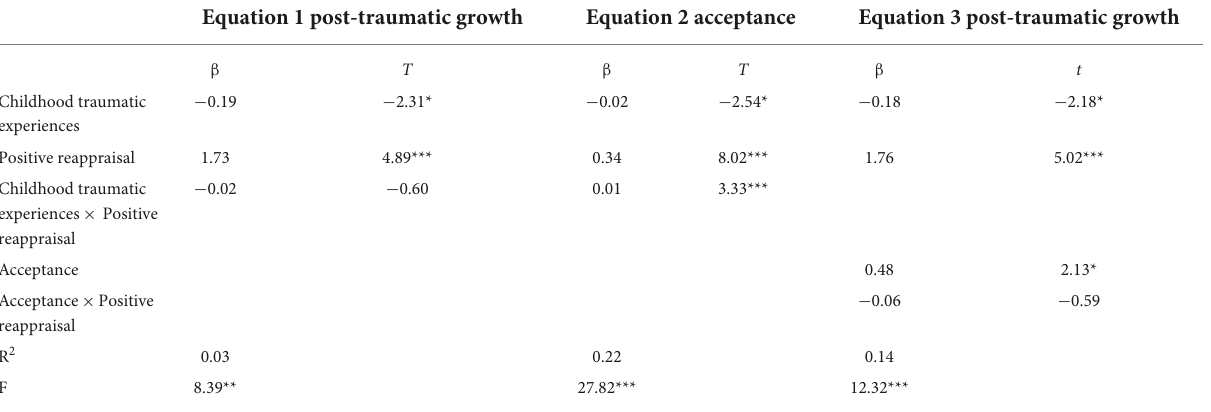
TABLE 6 Test for the moderating effect of positive